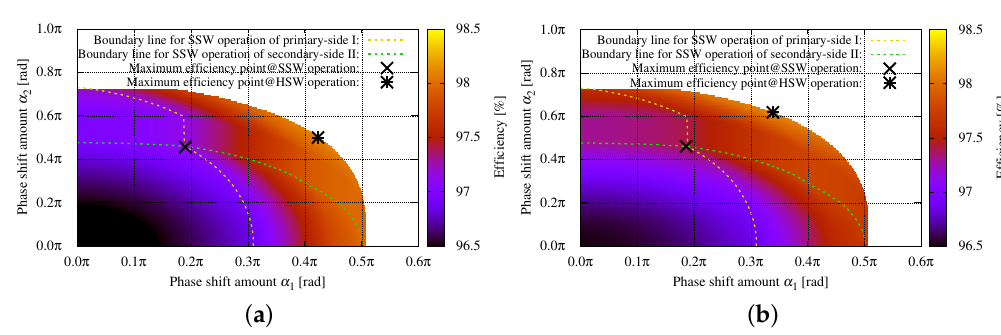
Boundary line for SSW operation of primary-side I: Boundary line for SSW operation of secondary-side II: Maximum efficiency point@SSW operation: